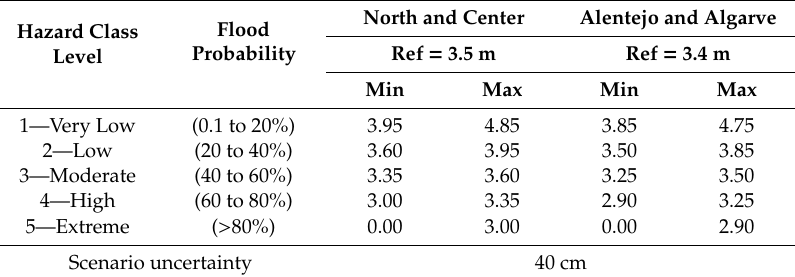
Table 7. Intervals for each EFHI class and respective probability for the SLR 2100 scenario with 100-year RP storm surge for each geographic zone, relative to the central reference flooding elevation level (the Ref value corresponds to the EFL central estimation).